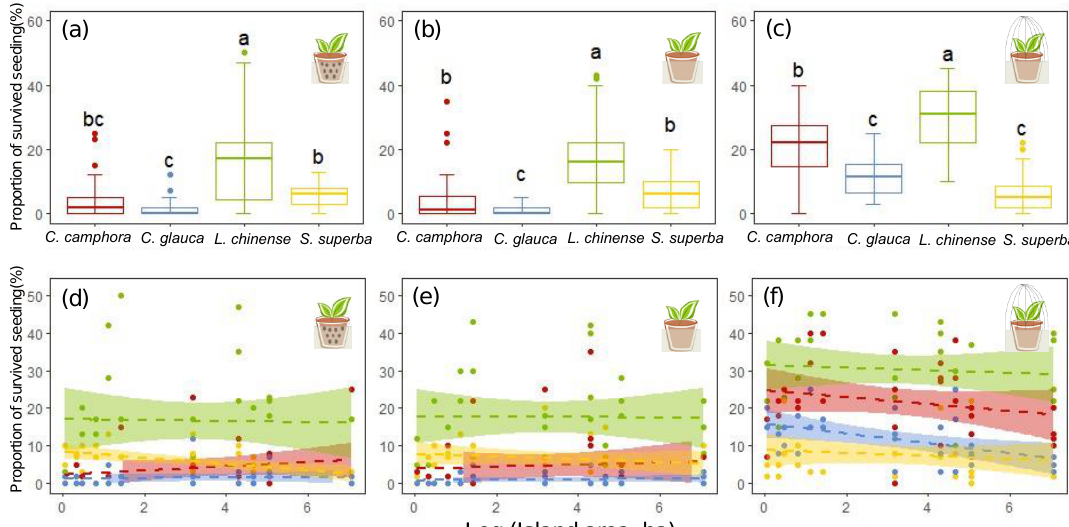
Figure 3. Differences in the proportion of surviving seedlings among the four species, and the relationship between the proportion of surviving seedlings and island area for species in the control ( a , d ), excluding root competition ( b , e ), and excluding herbivory ( c , f ) treatments. In ( a – c ), letters denote the significance (alpha = 0.05) of pairwise comparisons assessed using Tukey’s post-hoc comparisons. The dotted lines in ( d – f ) are the best fit linear regression lines and the shading indicates the 95% confidence intervals around the regression, the red dotted lines refer to the relationships for Cinnamomum camphora , blue dotted lines refer to the relationships for Cyclobalanopsis glauca , green dotted lines refer to the relationships for Loropetalum chinense , and yellow dotted lines refer to the relationships for Schima superba .